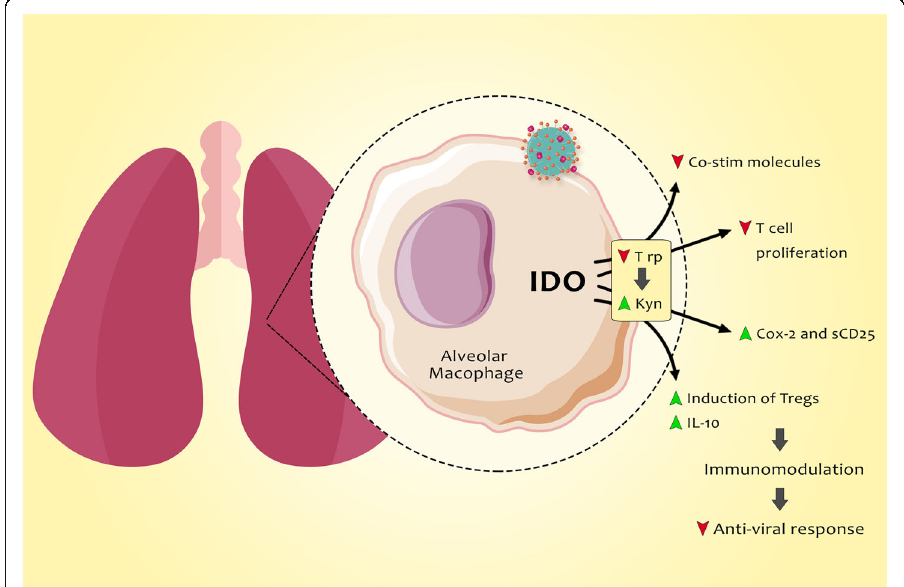
Fig. 3 Role of IFN in IDO activation. IFNs also induce activity of IDO, an enzyme that mediates the production of kynurenine from tryptophan. This event results in tryptophan depletion, which in turn develops the immune tolerance and generates